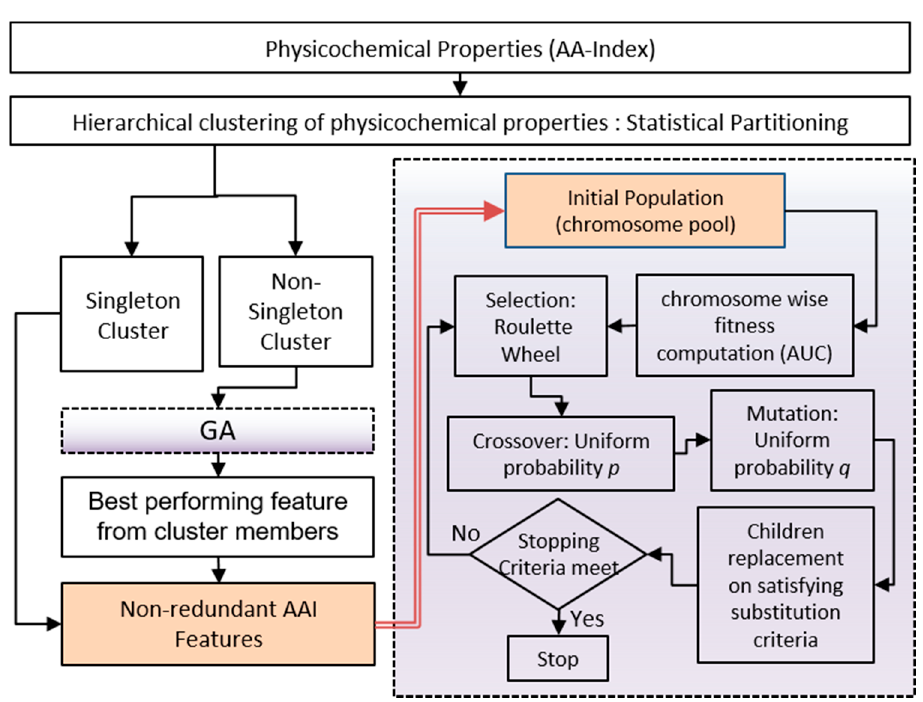
Figure 4. Detailed workflow of GA based feature selection.